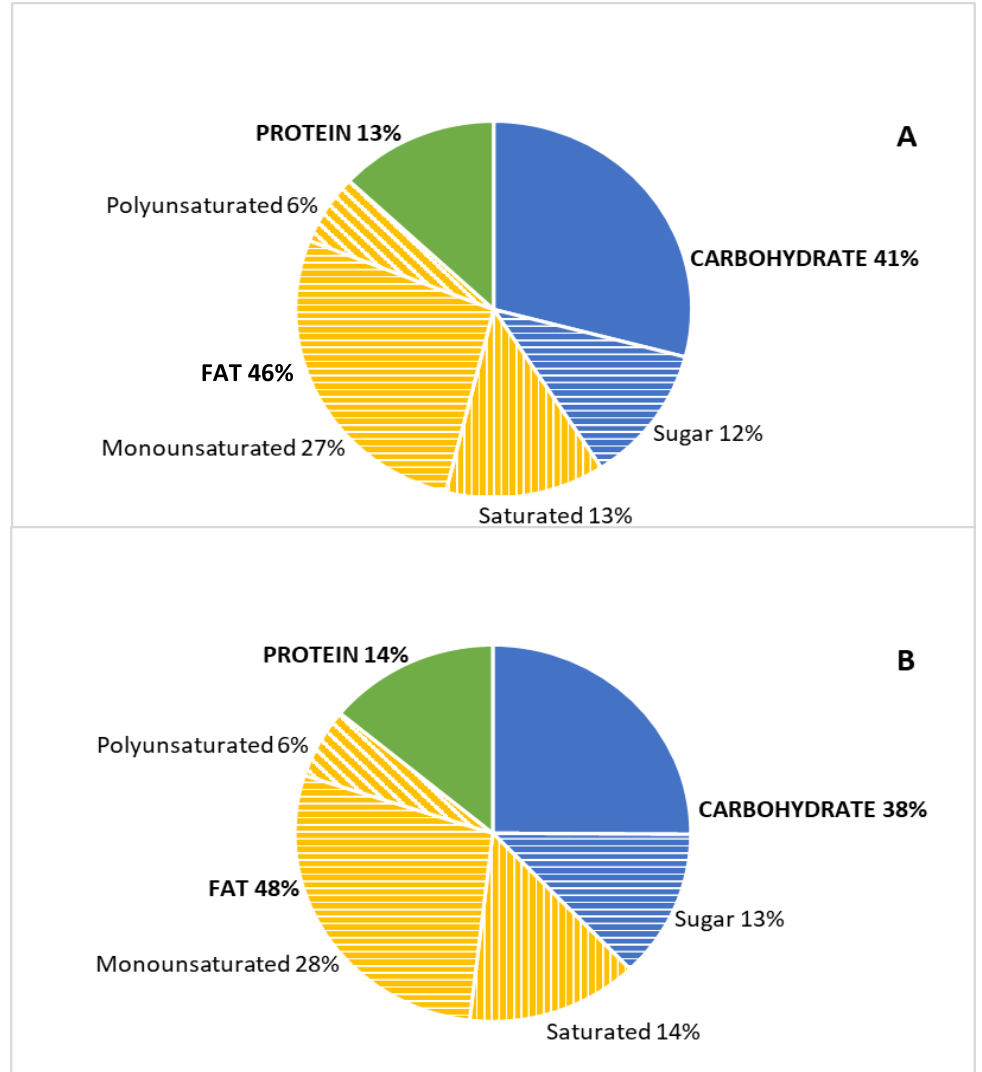
Figure 1. Percentage energy distribution of macronutrients in fasters ( A ) and non-fasters ( B ). Vitamin and element intakes are shown in Tables 2 and 3, respectively. The intakes of most vitamins (A, B 1 , B 2 , B 6 , B 12 , D, folate, and pantothenate) and percentage coverage of the corresponding RDAs were significantly lower in fasters compared to non-fasters (Table 2). Most participants (in both groups) did not meet the vitamin RDAs (as can be seen by the fact that the median was below 100%), except for vitamins B 1 , B 2 , and B 12 in non-fasters, as well as vitamin C in both